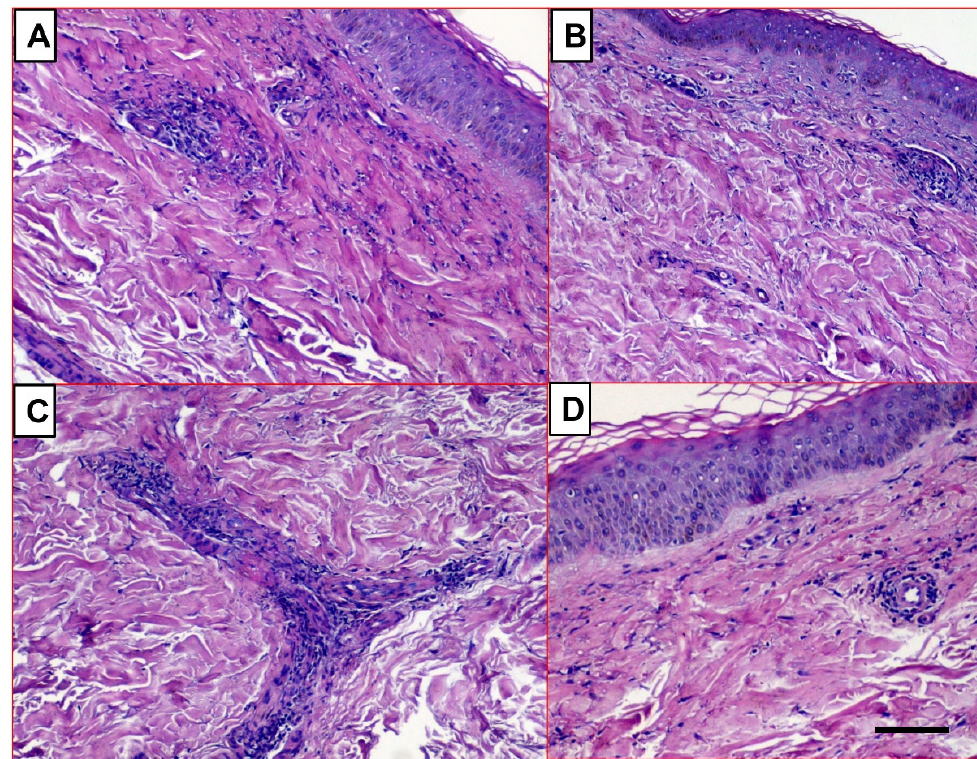
Figure 4. Skin biopsies showing leukocytoclastic vasculitis in SLE patients. The inflammatory lesions are evident in the perivascular derma, associated with nuclear dust and subepithelial myxoid degeneration. ( A , B ) original magnification: 40×, scale bar, 50 µm and ( C , D ) original magnification: 100×, scale bar, 25 µm.